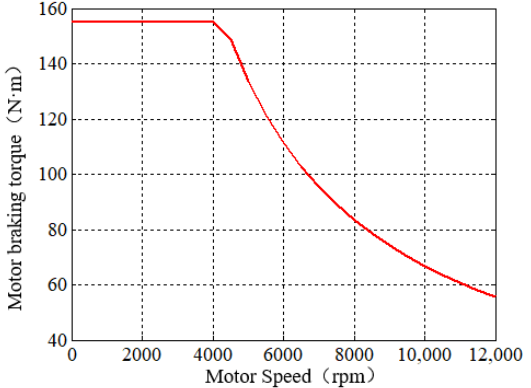
Figure 2. External characteristic curve of motor braking.